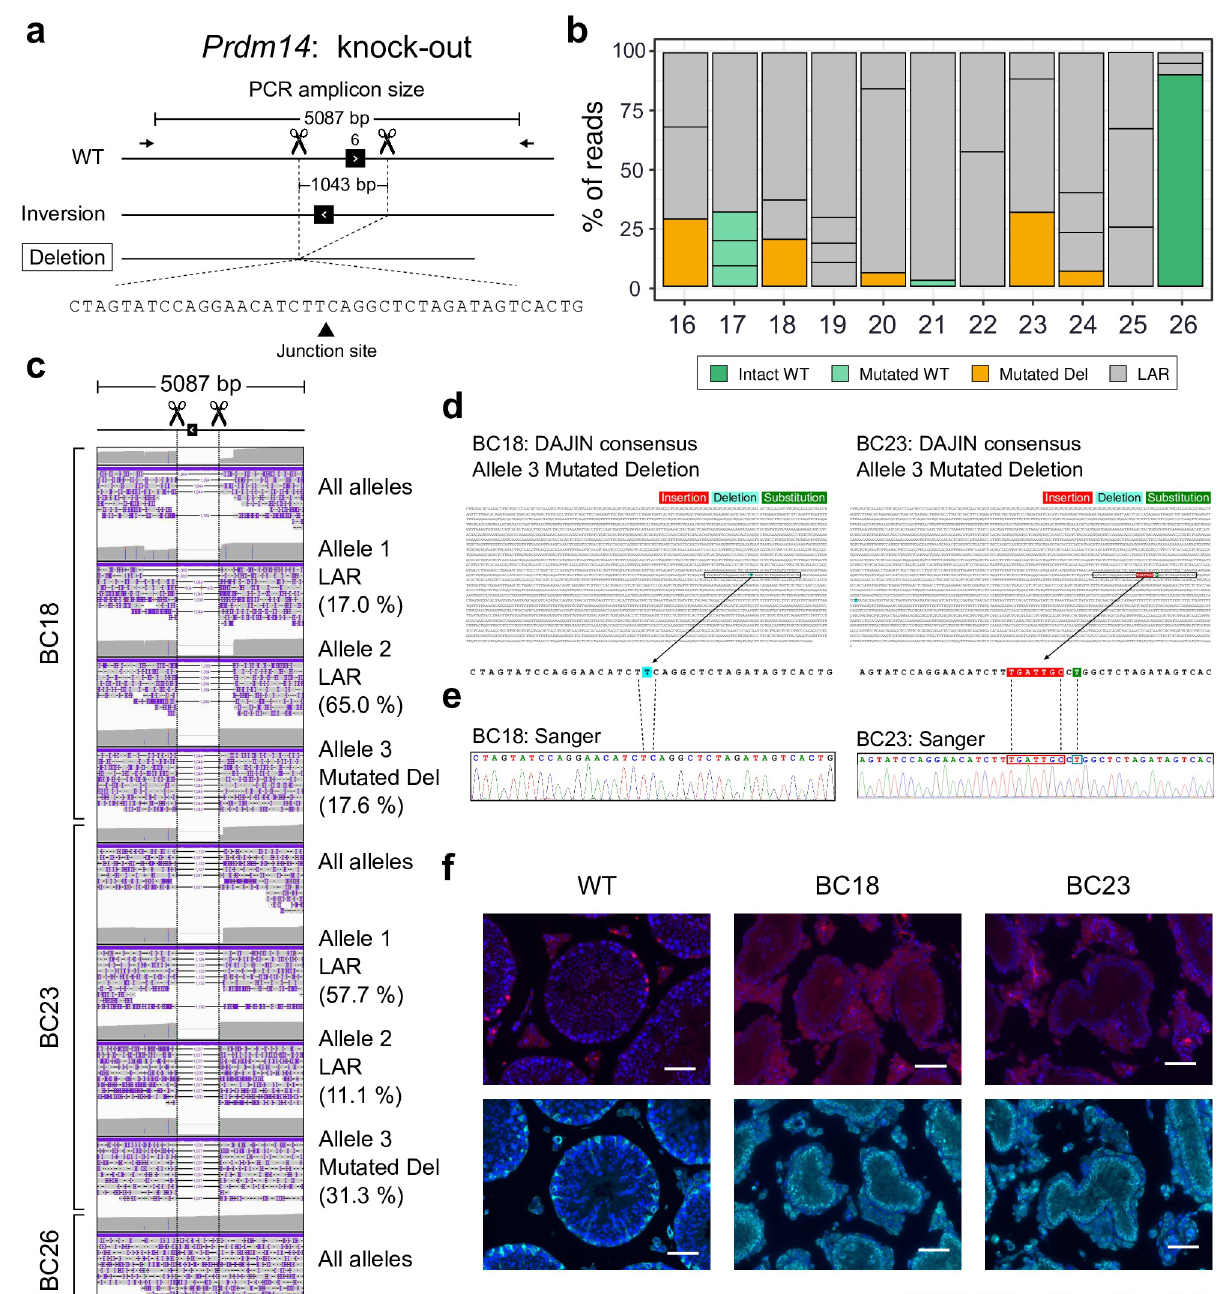
Fig 4. Application of DAJIN for KO design. (a) Genome editing design for Prdm14 KO. The scissors and dotted lines represent Cas9-cutting sites. The arrows represent PCR primers, including the size of the PCR amplicon. The boxed allele type represents the target allele. The inversion allele represents a possible by-product. The triangle on the nucleotides represents a junction site of 2 DNA fragments. (b) DAJIN’s report of the allele percentage. The barcode numbers on the x-axis represent mouse IDs. BC26 is a WT control. The y-axis represents the percentage of DAJIN-reported alleles. The colours of the bar represent DAJIN-reported allele types. The compartments partitioned off by horizontal lines in a bar represent the DAJIN-reported alleles. (c) Visualisation of nanopore sequence reads at Prdm14 target locus. BC18 and BC23 contain target alleles. BC26 is a WT control. The “All alleles” track represents all reads of each sample. The “Allele” track represents DAJIN-reported alleles. (d) DAJIN’s consensus sequences of the target allele. The top sequence represents the consensus sequence of target alleles of BC18 Allele 3 and BC23 Allele 3. The bottom sequences enlarge the boxed sequence of the consensus sequence. The colours on the nucleotides represent mutation types, including insertion (red), deletion (sky blue), and substitution (green). (e) Validation by Sanger sequencing. The dotted lines represent corresponding nucleotides between Sanger and DAJIN’s consensus sequences. (f) PLZF (red), Vimentin (green), and Hoechst (blue) staining of the testis section of WT (left), BC18